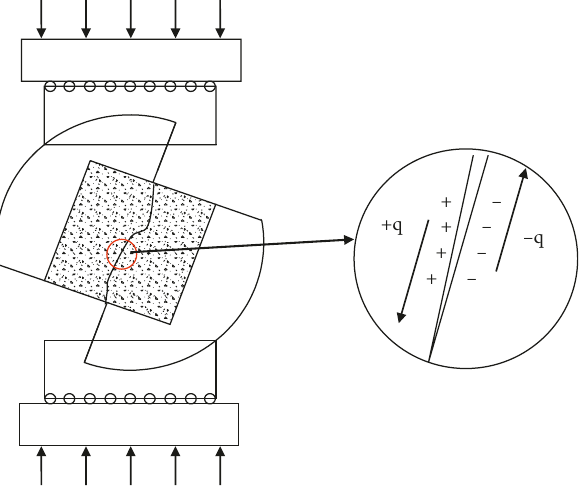
Figure 6: Direction of the electromagnetic field in shear